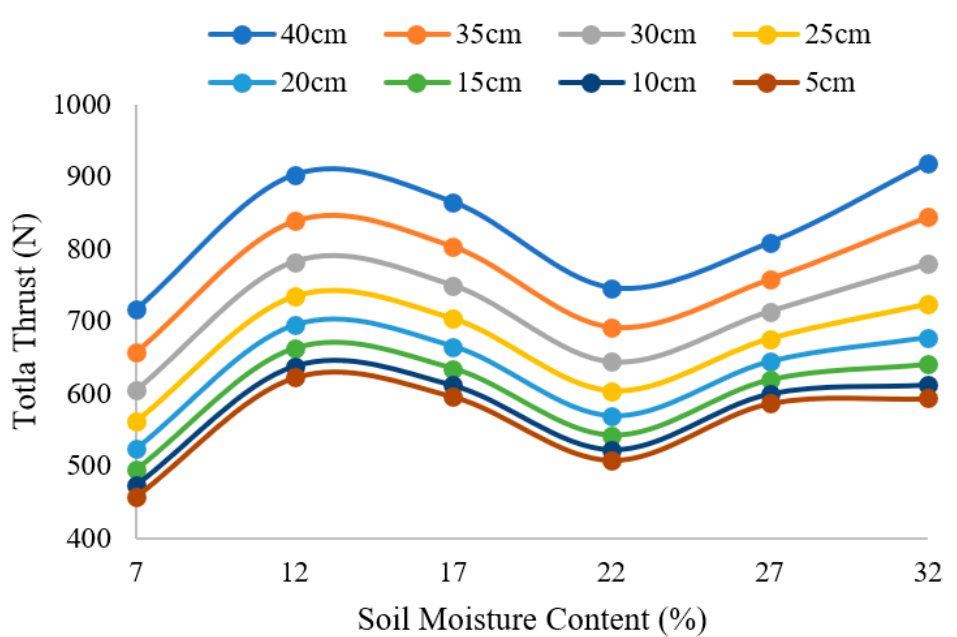
Figure 19. The thrust at different grouser heights with different moisture contents.